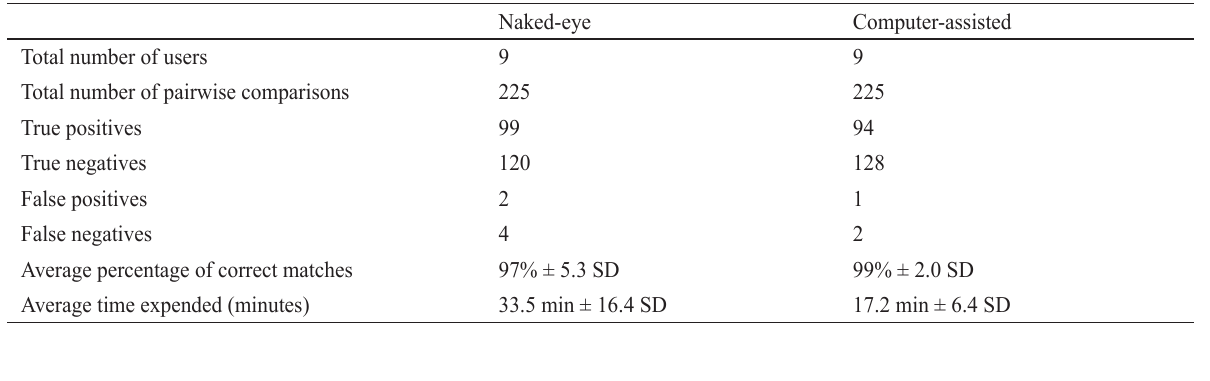
Table 1. Data on the field test for individuals of Rineloricaria aequalicuspis in which photo-identification efficacy was compared between naked-eye and computer-assisted technique. Data include number of photos compared by nine different users, number of correct matches (true positive and true negative) and misidentifications (false positive and false negative) and average percentage of correct matches and time expended.